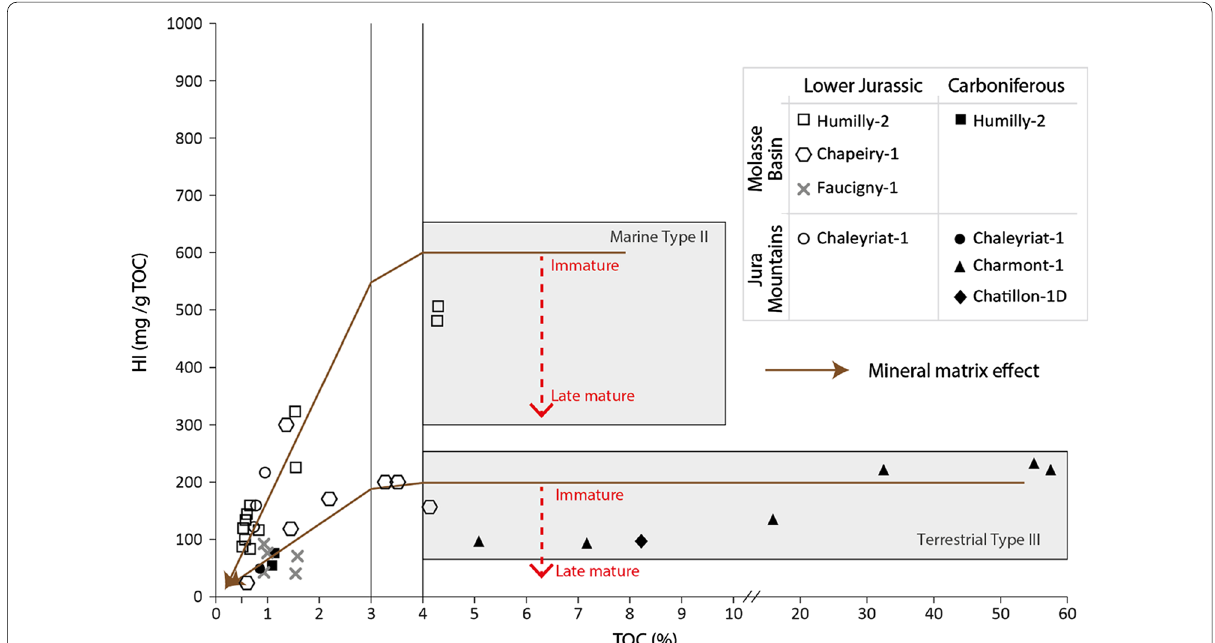
Fig. 10 Source-Rock potential diagram for samples with TOC > 0.5% showing the ranges of HI values for Type II and III OM when TOC above 4% (i.e. no mineral matrix effect). Brown arrows show the hypothetical effect of mineral matrix on HI values when TOC is lower than 4% and are based on previous works (Espitalié et al. 1985; Behar et al. 2020). Red arrows indicate the effect of maturity on HI